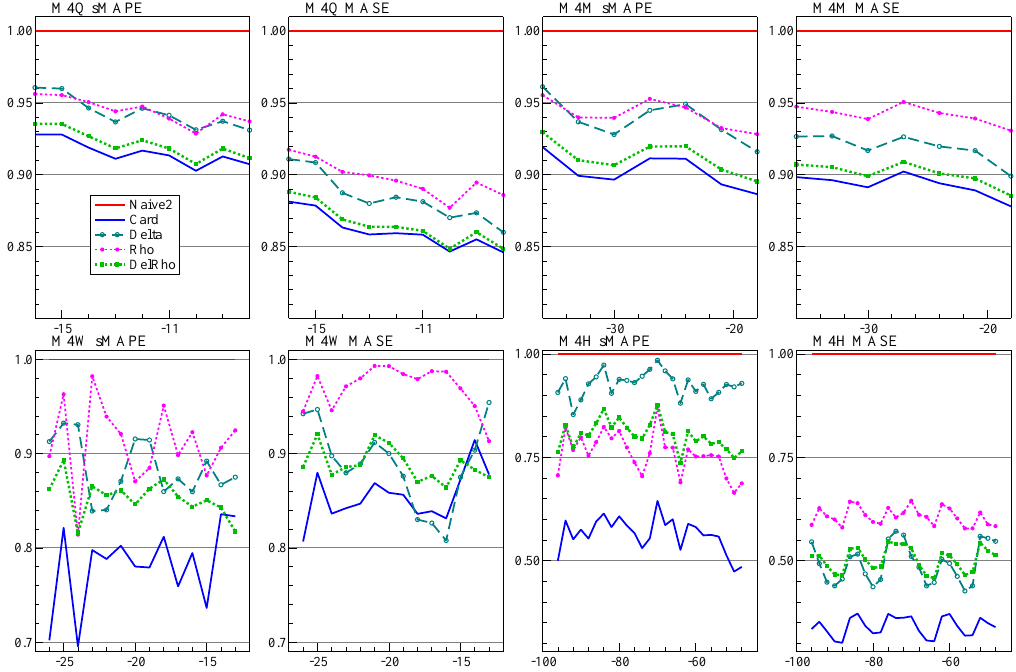
Figure 10. H -step performance relative to that of Naive2 for all seasonal data (M4Q, M4M, M4W, M4H for quarterly, monthly, weekly, hourly), retaining from 2 H to H observations for evaluation. Forecast methods are Delta , Rho , ( Delta + Rho ) /2, Card